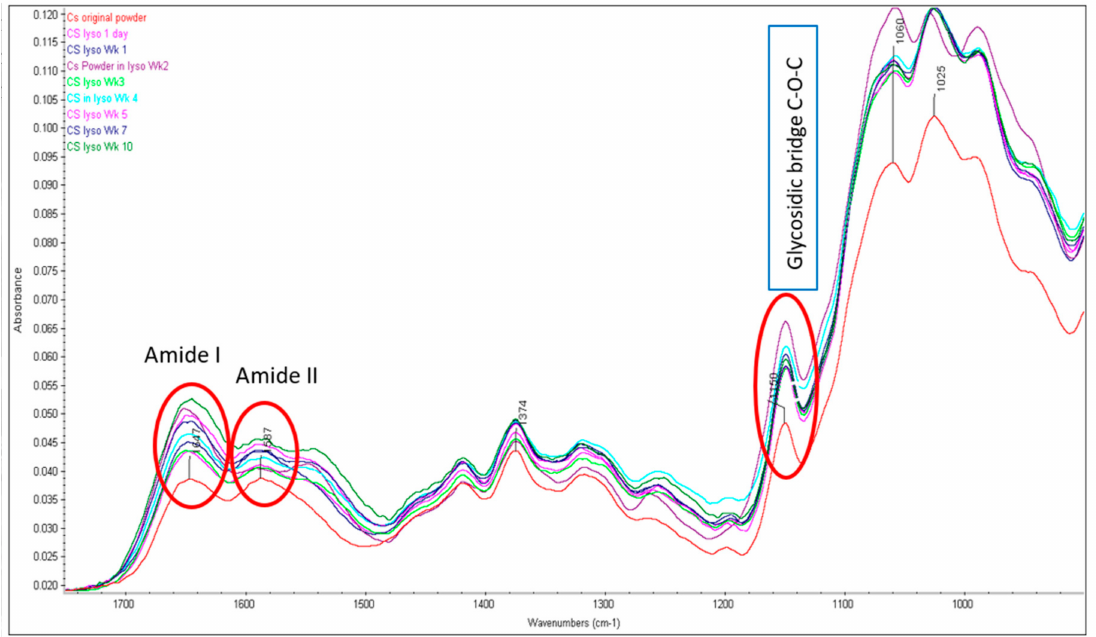
Figure 2. FTIR spectra of CS powders before and after lysozyme treatment (characteristic peaks for amide I, II and glycosidic bonds are